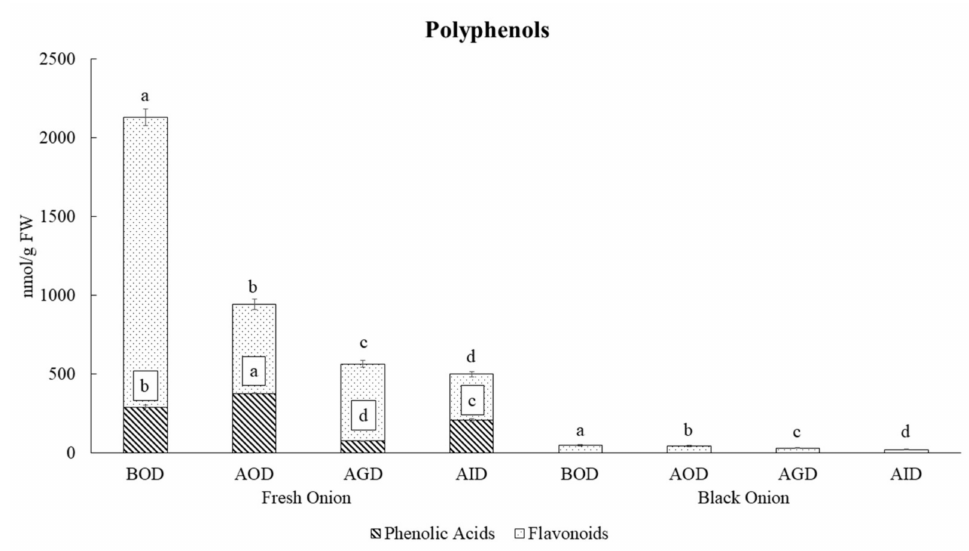
Figure 2. Quantities of phenolic acids and flavonoids during in-vitro simulated gastrointestinal digestion of fresh and black onion. Data are expressed in nmol/g FW as mean values ( n = 3). Different letters (one-way ANOVA) denote statistically significant differences between the stages of simulated gastrointestinal digestion ( p -value <